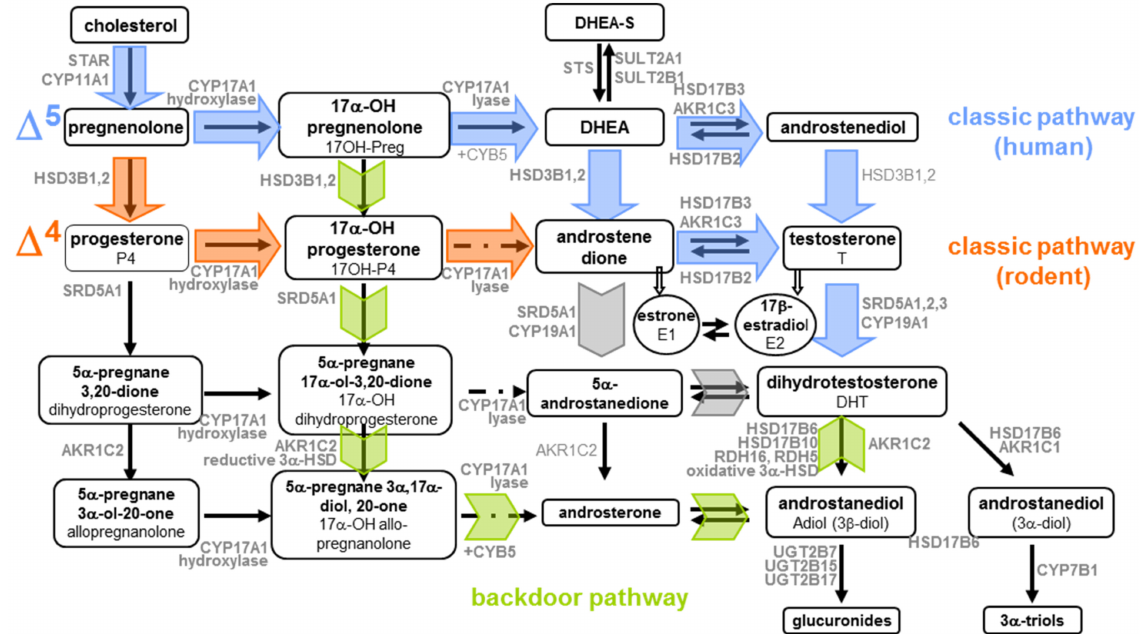
Figure 1. Summary of the principal gonadal steroidogenic pathways. Steroid precursors and metabolites from the classic delta 4 (orange arrows) and delta 5 pathways (blue arrows) are shown together with the backdoor (alternative) pathway (green